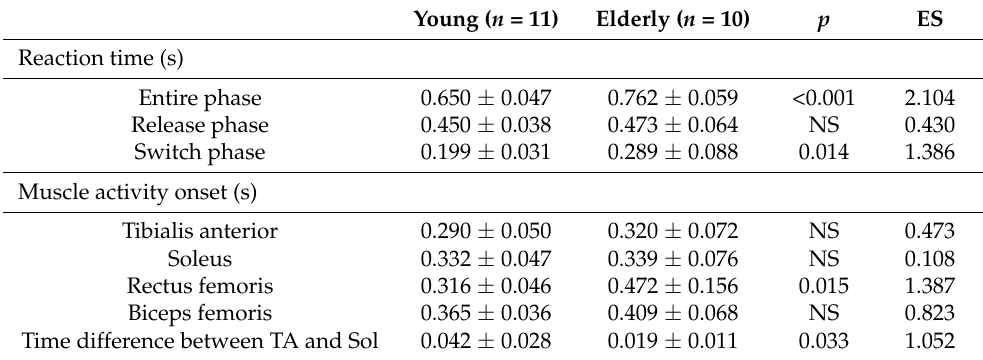
Table 2. Times of reaction and muscle activity onset during emergency braking.